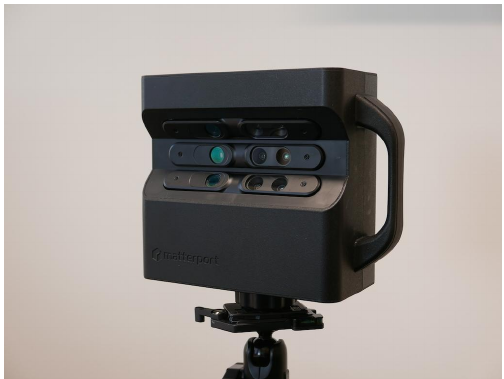
Figure 3. Matterport.